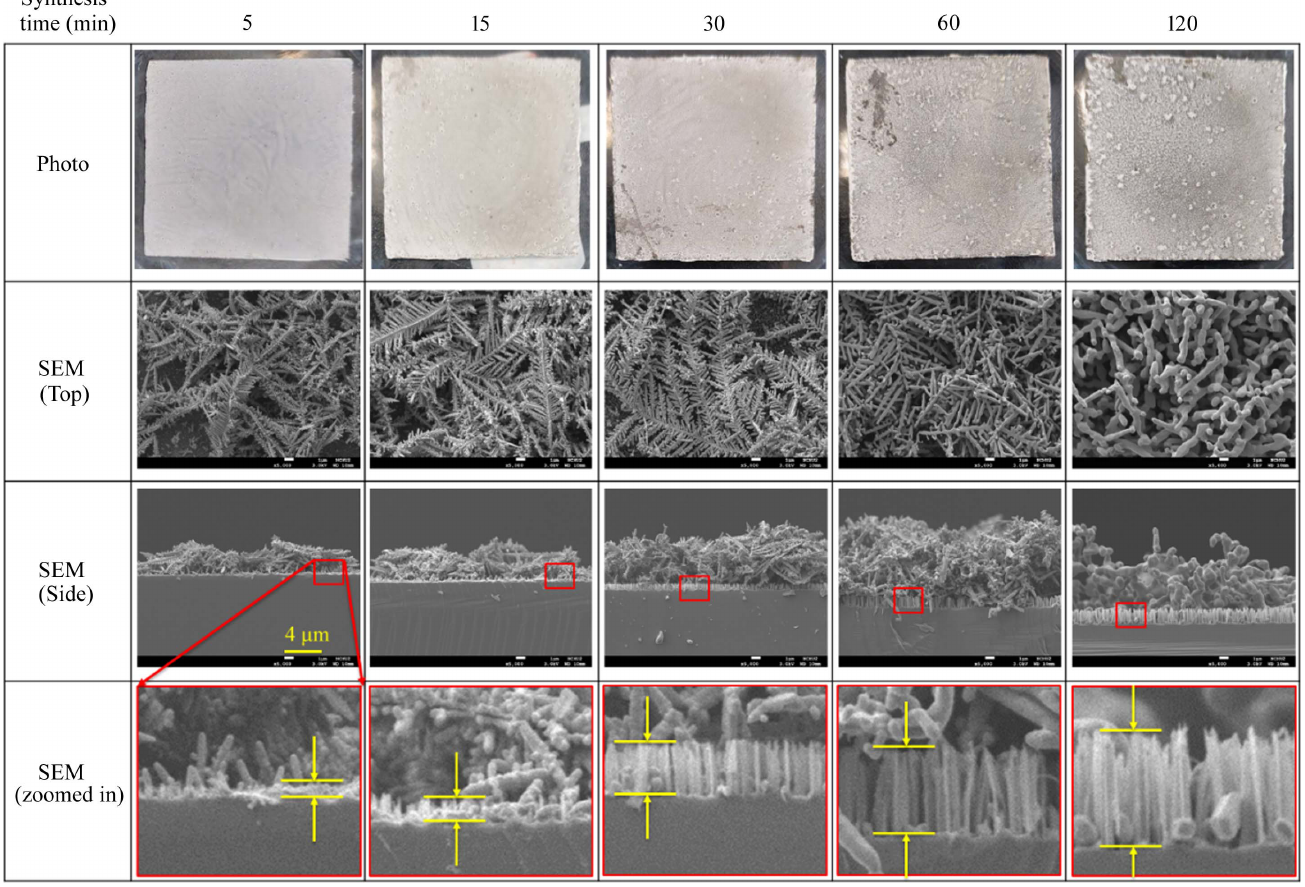
Figure 1 Top-view photographs and SEM images (top and side views) of Ag–dendritic nanoforest (DNF)/Si samples fabricated with various synthesis